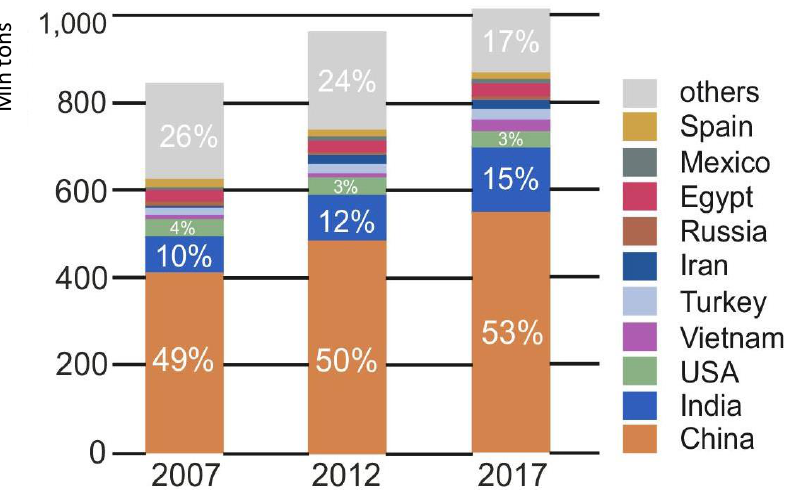
Figure 1. The ten main producers of vegetables